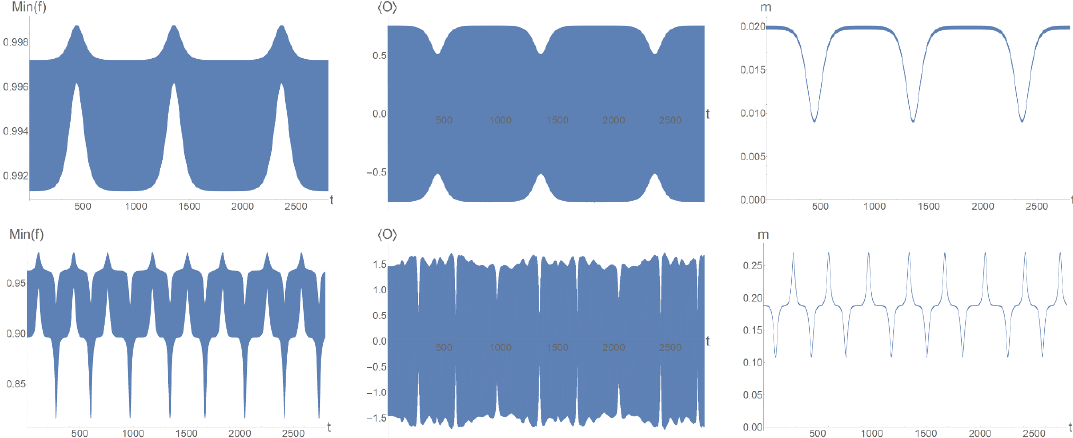
Figure 34 . Sourced modulated solutions (SMS) with (cid:26) b = 10 (cid:0) 3 . In the (cid:12)rst line we depict a standard SMS with ! b = 2 : 944 and (cid:26) o = 0 : 15. The blue (cid:12)lling corresponds to the fast oscillations of the scalar (cid:12)eld (as compared to the pulsating modulation). In second line, we provide an example of an exotic SMS, where pulsating modulations of both signs alternate. The unstable initial SPS has, in this case, ! b = 2 : 722 and (cid:26) o = 0 :